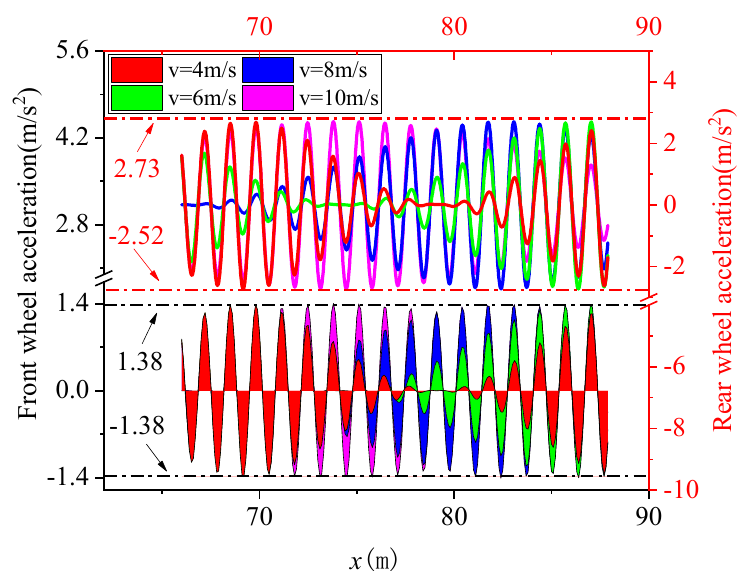
Figure 13. Net vertical acceleration of front and rear wheels at different speeds 2 ns ≤ x ≤ 2 ns + ( b + c ) ( n ∈ N* ).